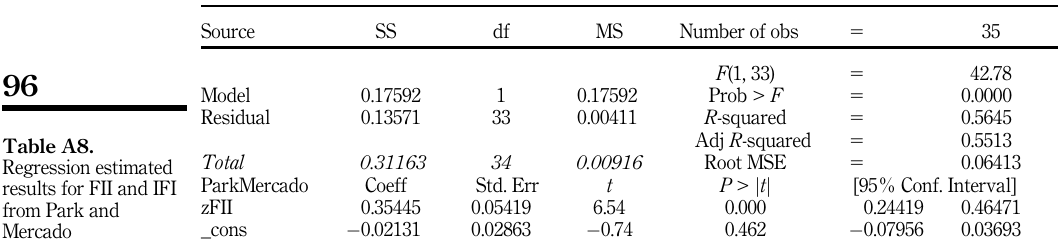
Table A8. Regression estimated results for FII and IFI from Park and